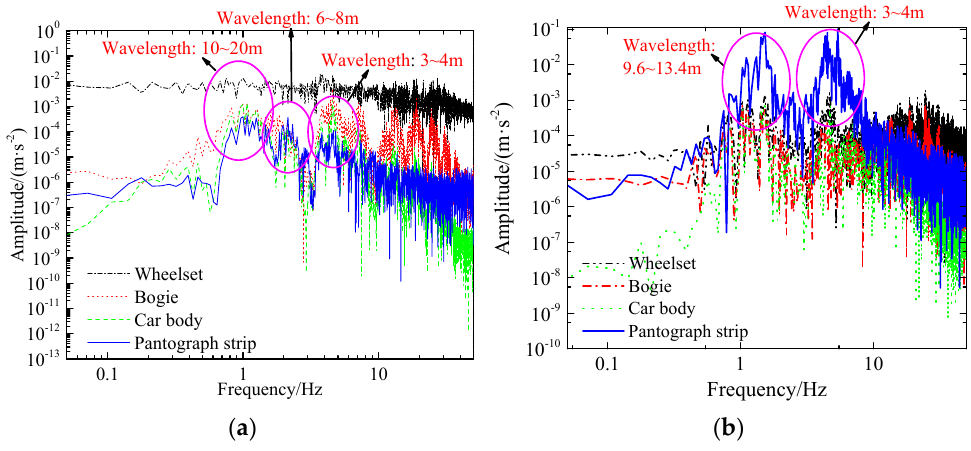
Figure 9. Vibration responses of the vehicle system at 53 km/h: ( a ) vertical responses; ( b ) lateral responses.